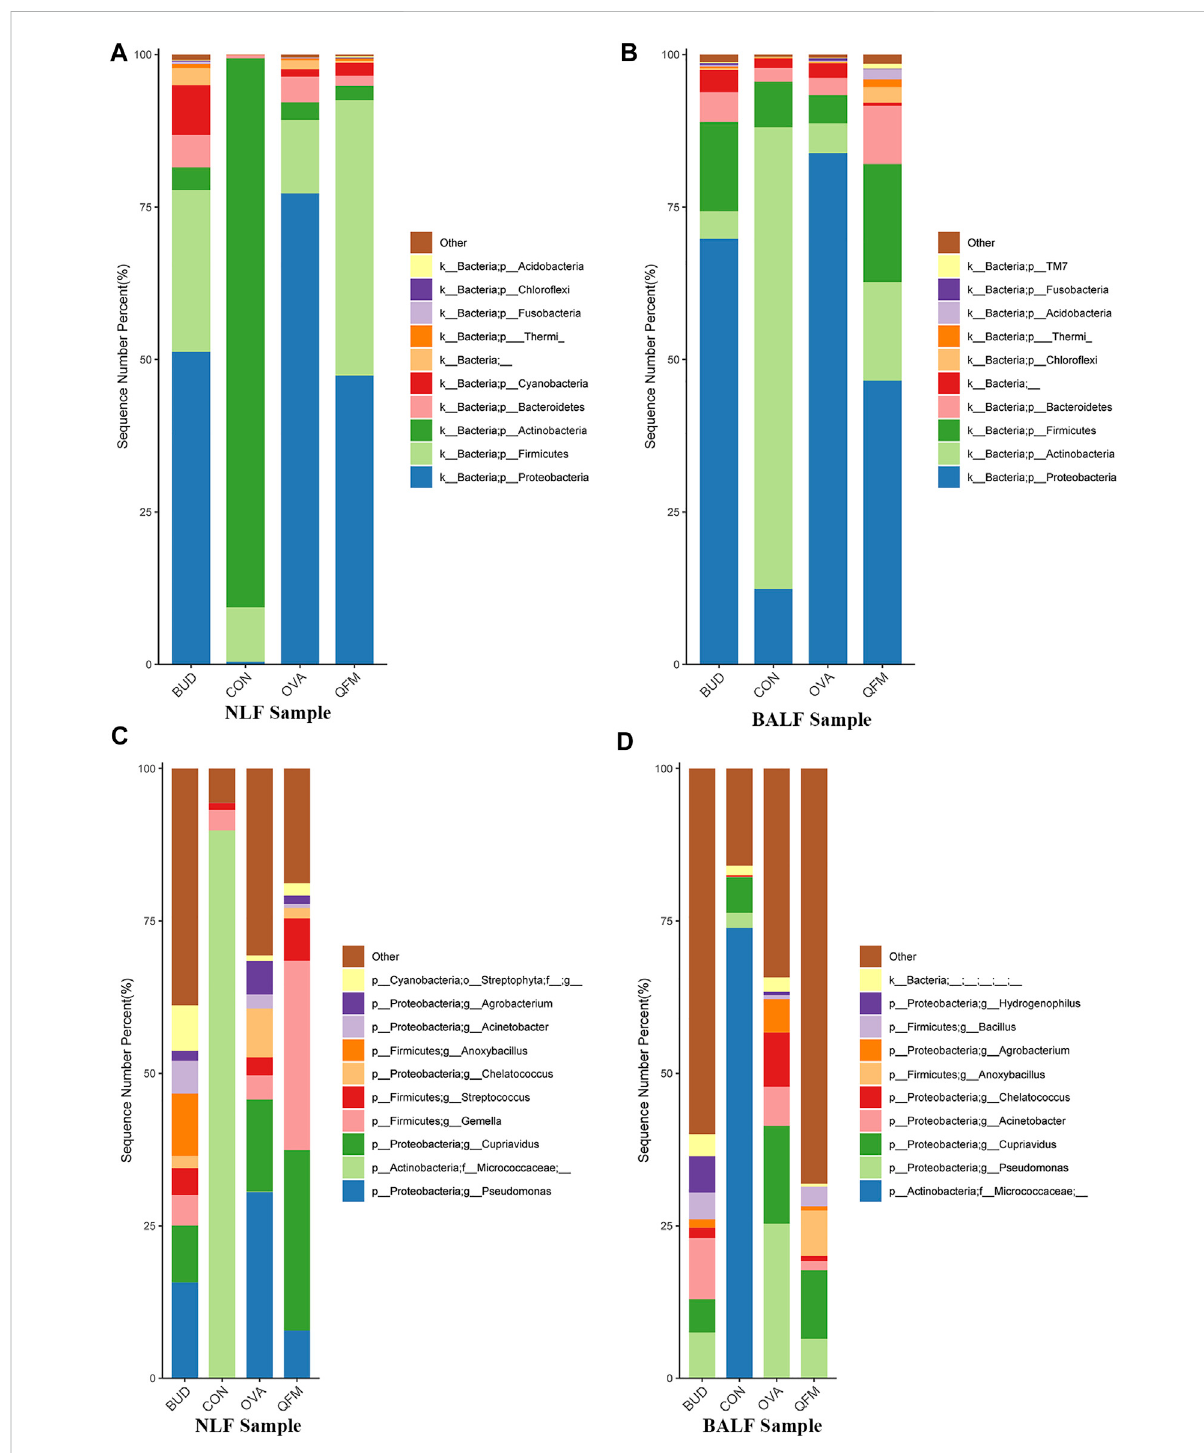
FIGURE 5 Effects of Qingfei oral liquid (QF) on the composition of respiratory microbiota in ovalbumin (OVA)-induced asthmatic mice. (A) The composition of nasal lavage fl uid (NLF) microbiota at the phylum level. (B) The composition of bronchoalveolar lavage fl uid (BALF) microbiota at the phylumlevel. (C) ThecompositionofNLFmicrobiota atthegenuslevel. (D) ThecompositionoftheBALFmicrobiotaatthegenuslevel.( n =5ineach group; only the top 10 legends with high abundance are